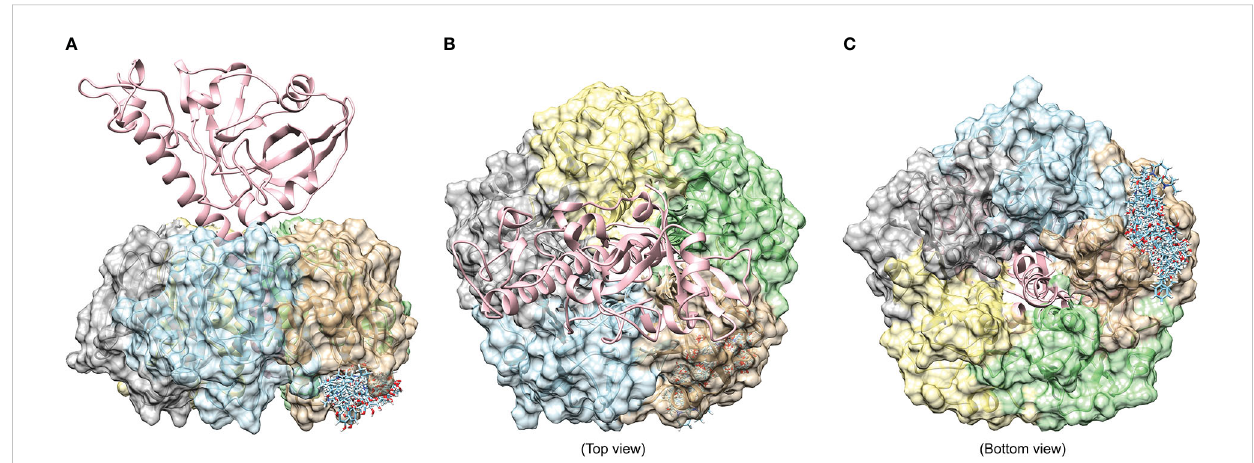
FIGURE 1 Binding of 20 phytocompounds to the largest binding pocket at chain F of 1XTC. (A) shows the front view, while the top (B) and bottom view (C) are also shown to highlight the orientation and architecture of whole CT having one alpha and fi ve subunits of beta